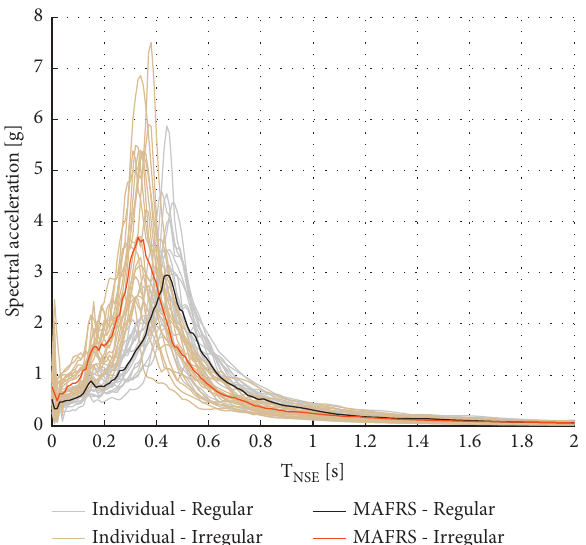
Individual - Regular MAFRS - Regular Individual - Irregular Figure 8: NLTHA-driven AFRS and comparison with those for an irregular structure counterpart.